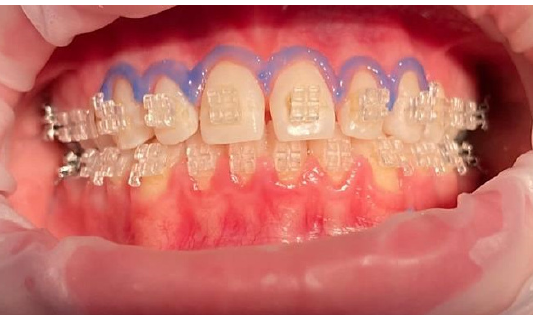
Figure 4. Clinical aspect of the dental units included in the study with the gingival barrier, before the debonding